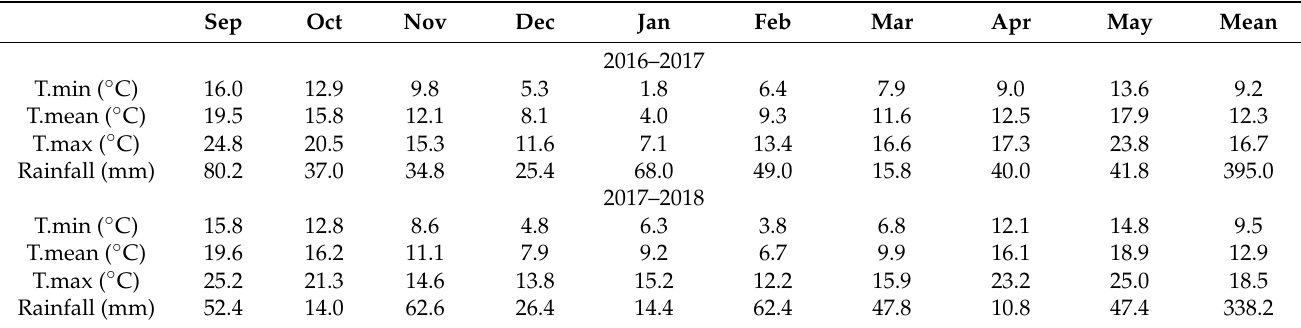
Table 2. Monthly minimum, mean and maximum air temperature and total rainfall recorded during two experimental years (2016–2017 and 2017–2018) in